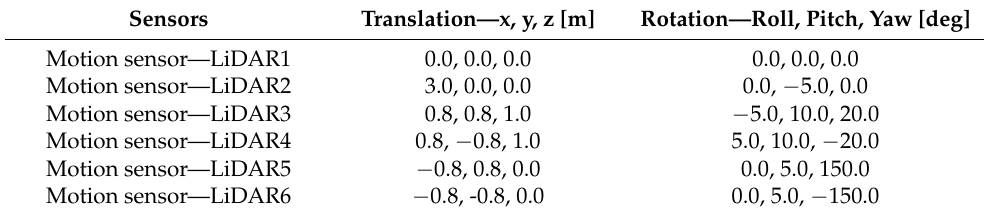
Table 2. Calibration parameter between one motion sensor and six LiDARs.